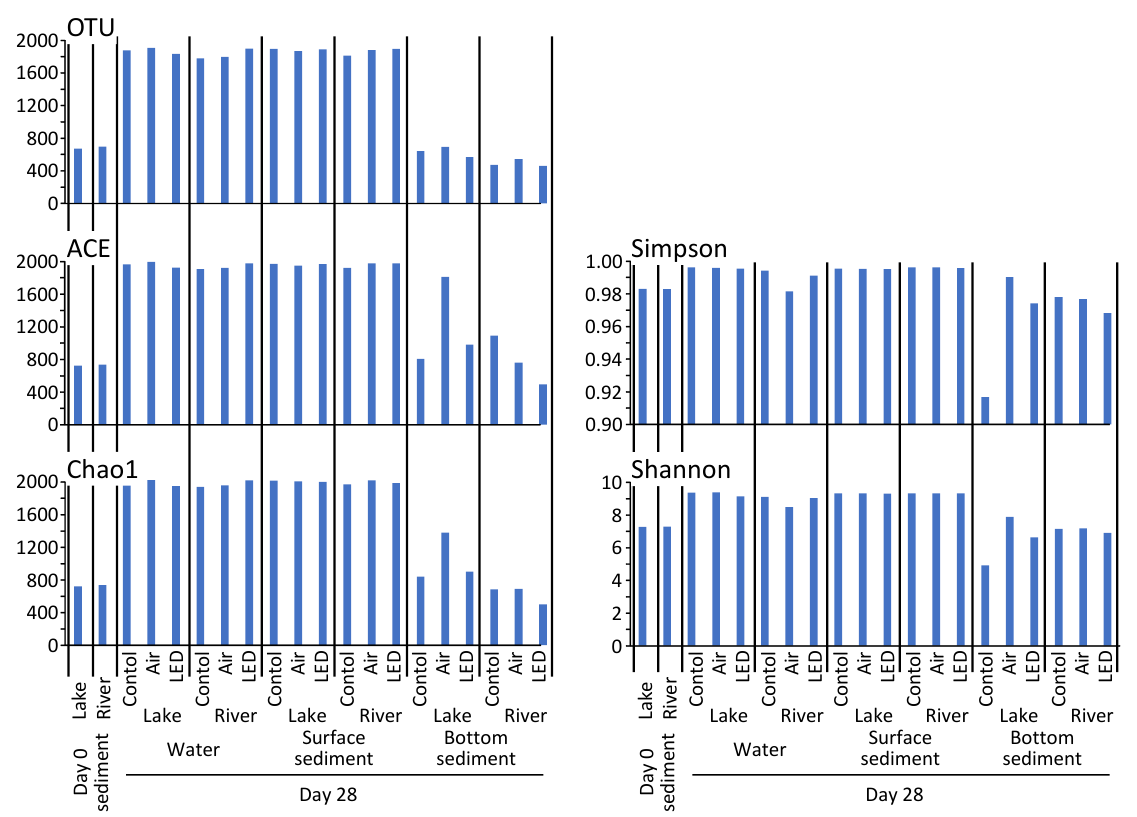
Figure A1. Sediment quality (( a ): organic content, ( b ): TN, ( c ): TP) at the beginning and end of the experiment.